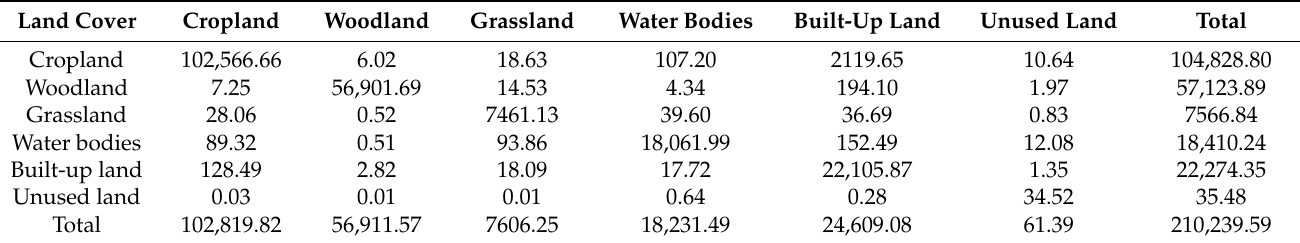
Table 6. Land conversion in Yangtze River Delta Region (2010–2015) (area: km 2